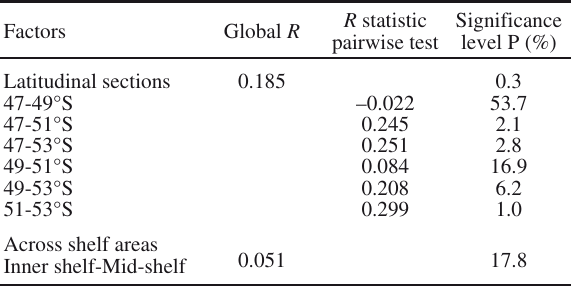
Table 2. – Analysis of similarity (ANOSIM test) performed to test Table 4. – PCA ordination of dominant copepod species. Entries are for significant differences in the copepod community structure eigenvalues of the correlation matrix between the ln-transformed among latitudinal sections and shelf areas. For detailed derivation abundance values of dominant copepod species and the PCA Axes 1 of groups see Materials and Methods. All values of R in the pairwise and 2. Species contributing most to axis placement and consequent tests are significant at P = 0.05%. ordination are in